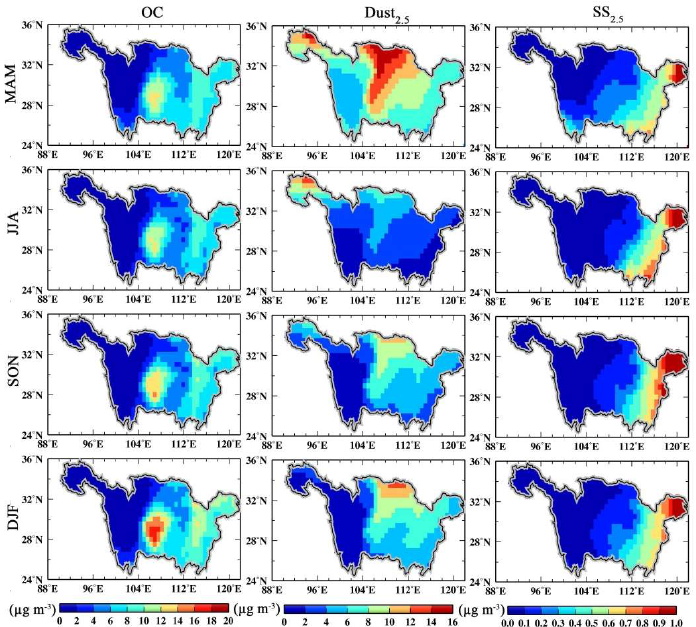
Figure 8. Seasonal variations of each MERRA-2 PM 2.5 component: ( left ) OC, ( middle ) Dust 2.5 and ( right ) SS 2.5 .